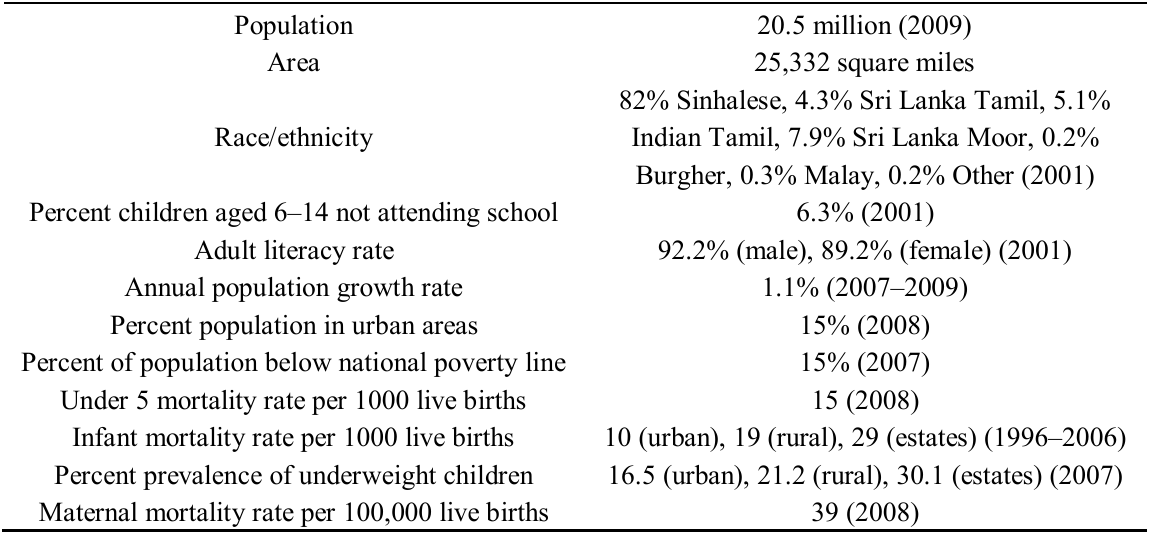
Table 1. Sri Lanka Demographic and Development